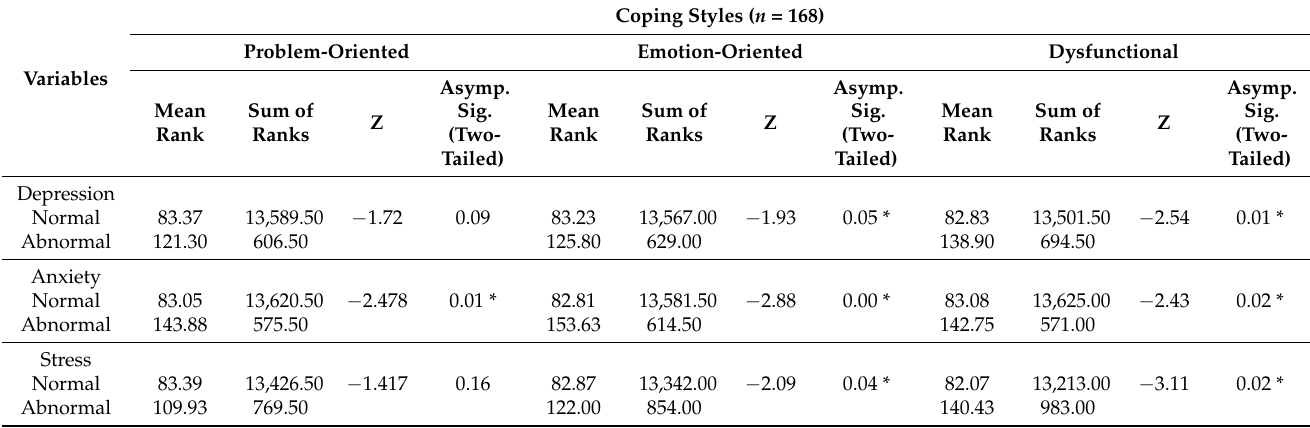
Table 9. Association between psychological distress and coping styles.